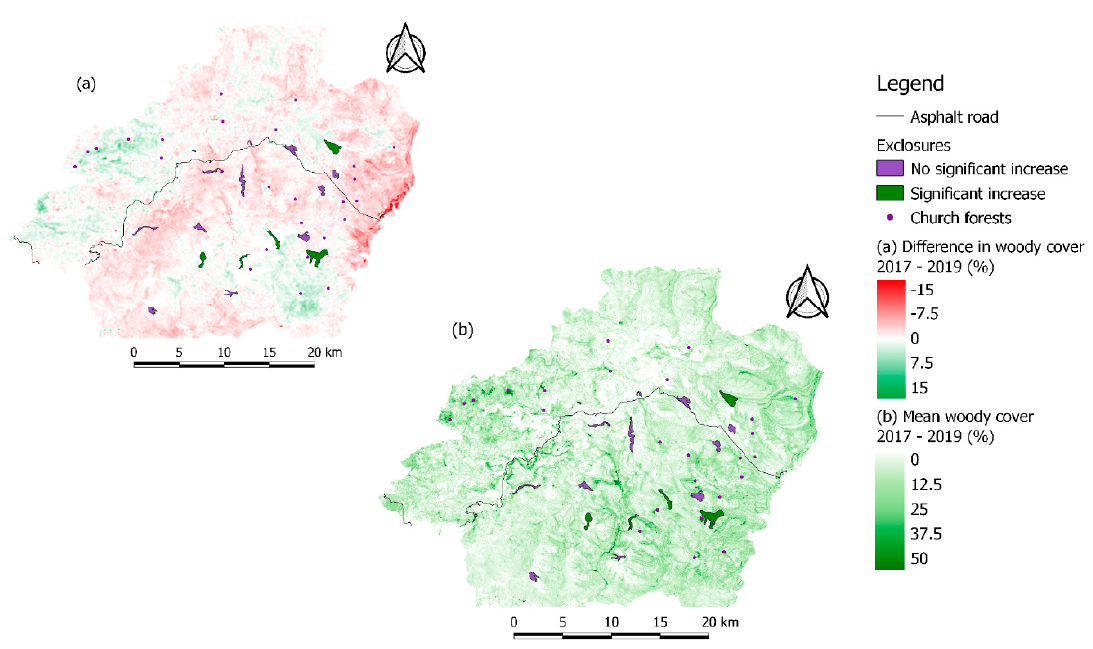
Figure 2. ( a ) Map of the difference in predicted woody cover between 2017 and 2019; ( b ) Map of the mean woody cover between 2017 and 2019, together with the location of the 17 exclosures and 25 church forests included in the analysis.